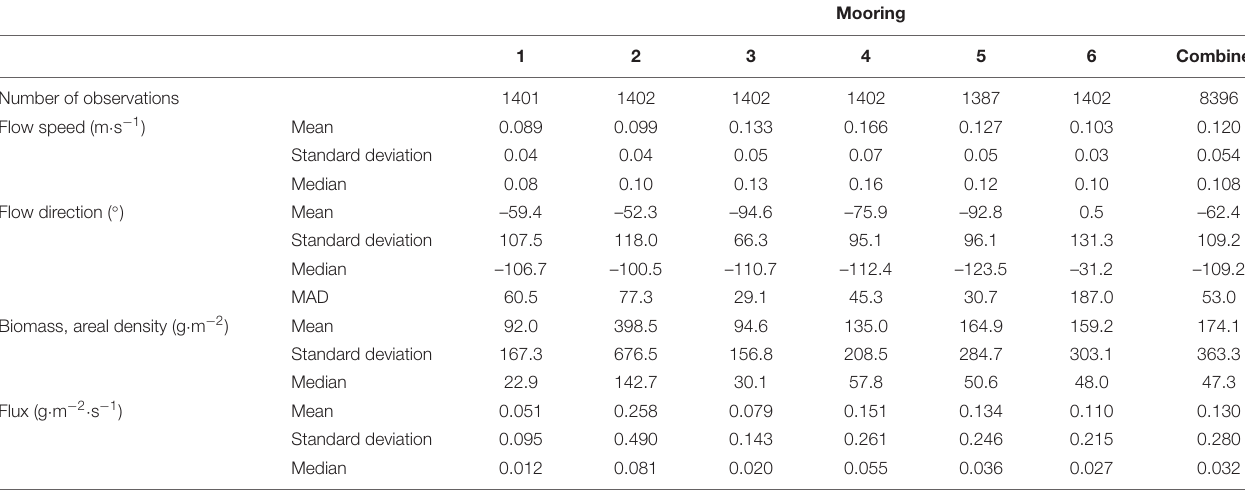
TABLE 4 | Krill biomass, flux, and flow.